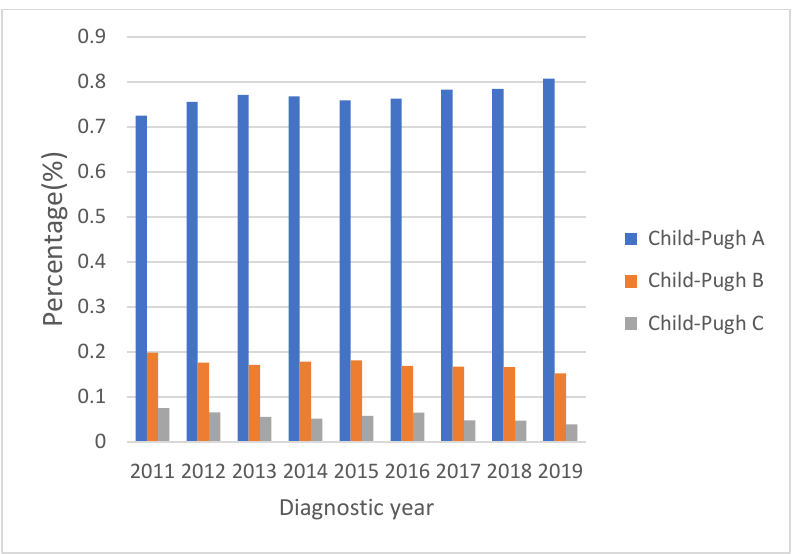
Figure 2. Child–Pugh classification from 2011 to 2019 shows liver function reserve improved over time (all p values for linear trend <0.01). Proportion of Child–Pugh class A increased from 72.5% to 80.7%. The proportions of Child–Pugh B and C decreased from 19.9% to 15.3% and from 7.6% to 4.0%, respectively.